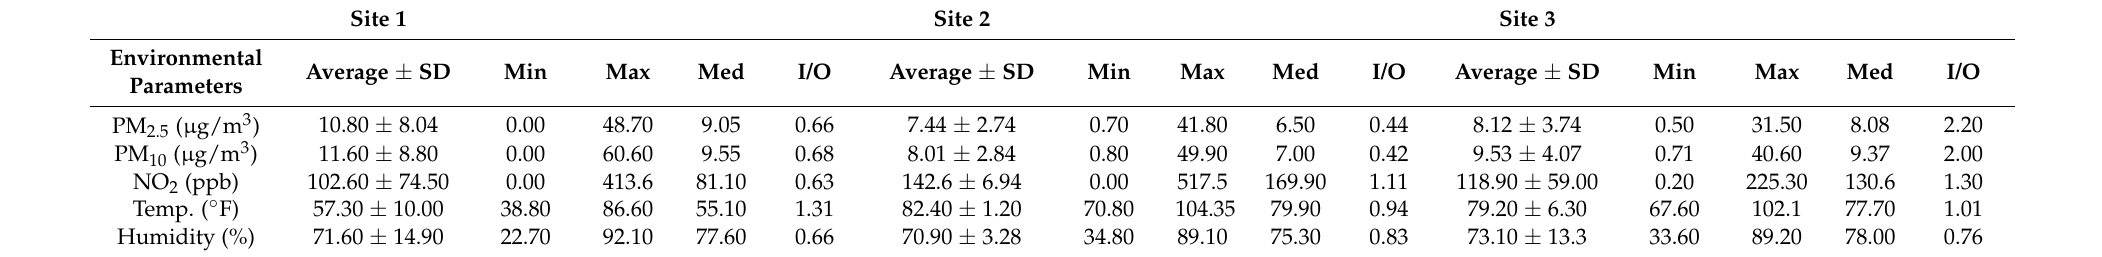
Table 4. Descriptive statistics of outdoor environmental parameters measured at sites 1, 2, and